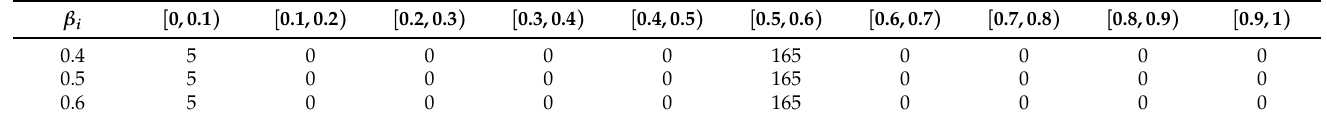
Table 5. Number distribution of all individuals in different ranges when β i varies from 0.4 to